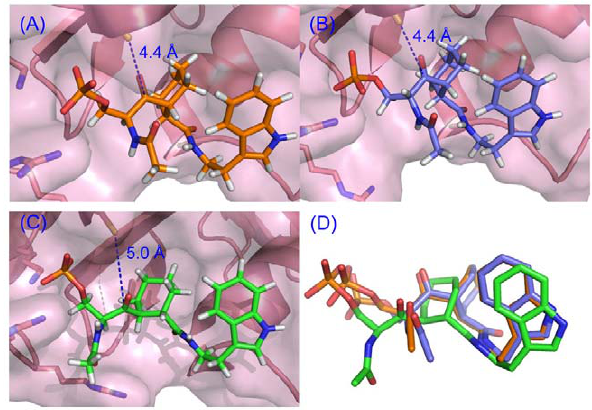
Figure 5. Models of cyclohexyl ketone inhibitors were docked with dynamic minimization. (A) (1 S, 3 R, 4 R )-1 in orange, (B) (1 R, 3 R, 4 R )-2 in blue, (C) (1 S, 3 S, 4 S )-2 in green, and (D) superposition of all atoms of 1 and rac -2 . Models were based on PDB 2Q5A [32], and minimized using Sybyl 8.1.1 [42]. Images were prepared using MacPyMol